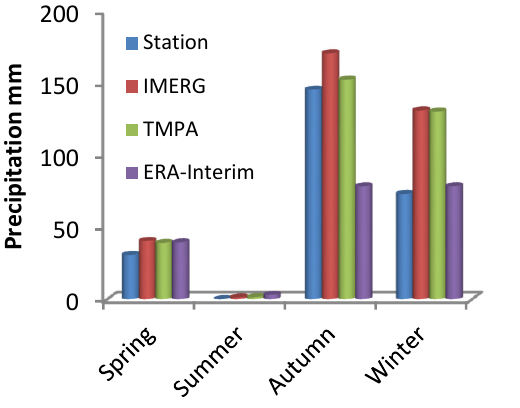
Figure 14. Kermanshah seasonal precipitation. Table 15. Statistical indices of seasonal precipitation in Tehran area.